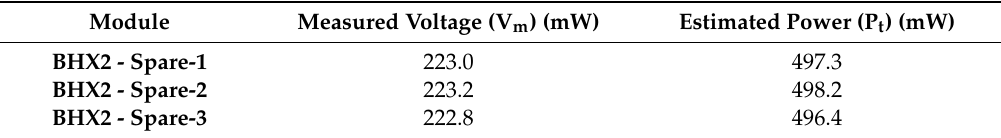
Table 1. Radio-module tests results—RF power output.